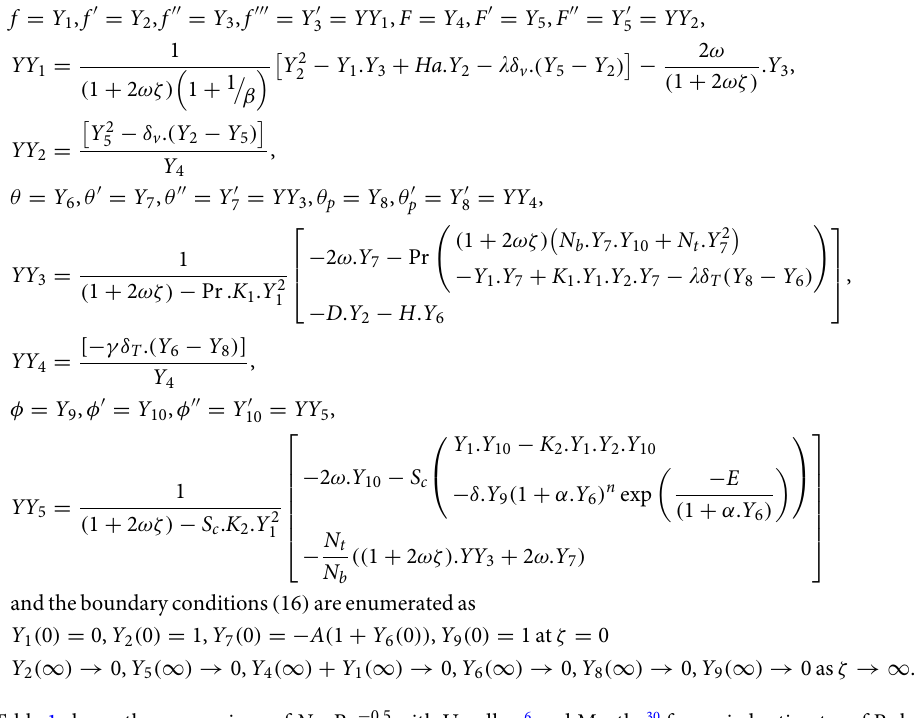
Table 1 shows the comparison of Nu x Re − 0.5 x with Upadhya 6 and Murthy 30 for varied estimates of Pr by fix-